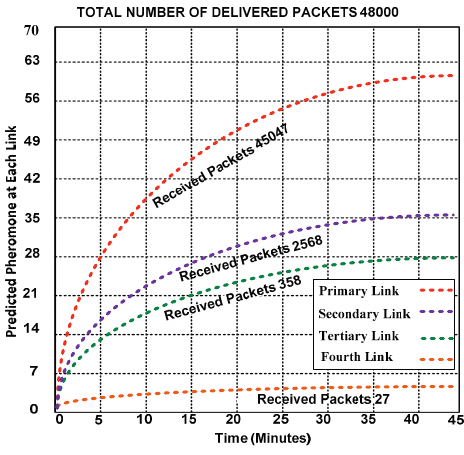
Figure 7. Predicted pheromone on multiple links.